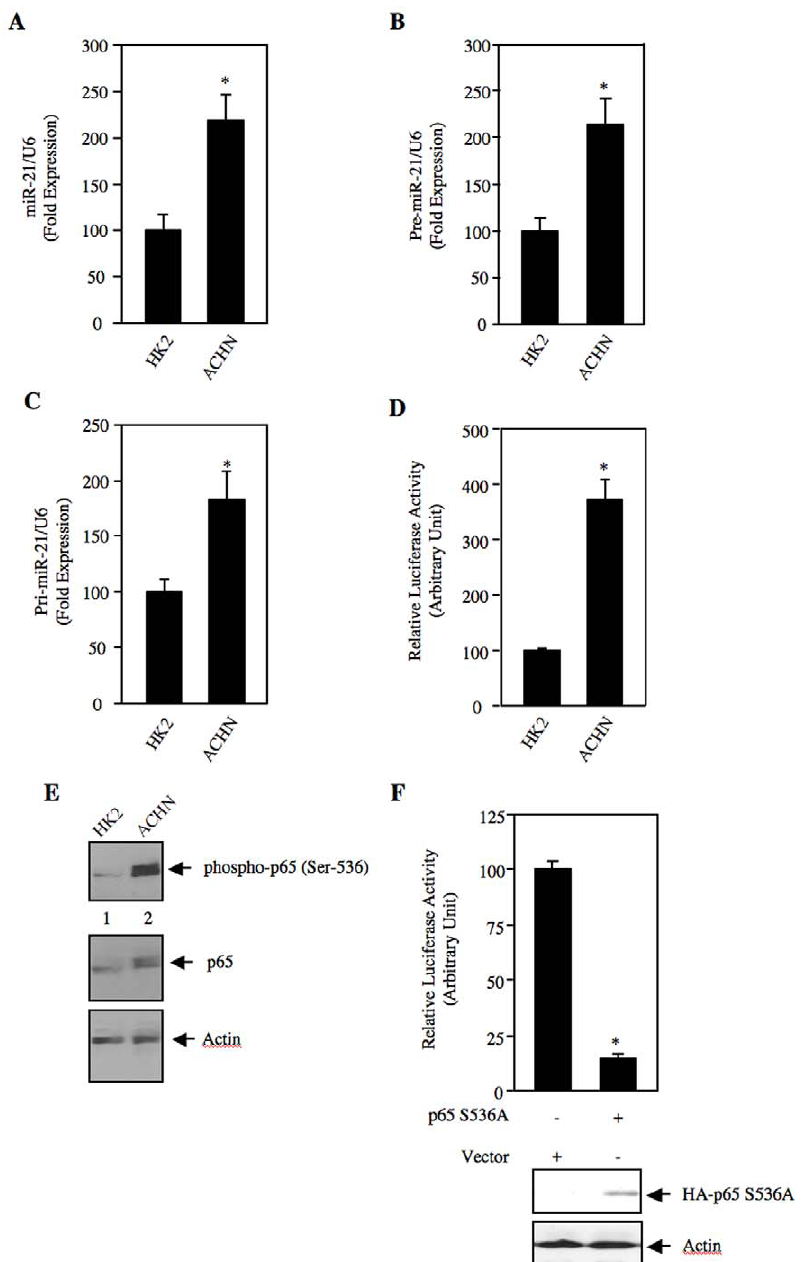
Figure 1. Expression of miR-21 in renal cancer cells. (A – C) Total RNAs from HK2 proximal tubular epithelial cells and ACHN renal cancer cells were used to detect mature miR-21 (panel A), pre-miR-21 (panel B) and pri-miR-21 (panel C) by real time qRT-PCR as described in the Materials and Methods. Mean 6 SE of 4 measurements is shown. In panels A and B, *p =0.004 vs HK2 cells. In panel C, *p =0.02 vs HK2 cells. (D) HK2 and ACHN cells were transfected with miR-21-Luc reporter along with Renilla null plasmid. The cell lysates were used to determine luciferase activity as described in the Materials and Methods. Mean 6 SE of 6 measurements is shown. *p =0.001 vs HK2 cells. (E) Increased phosphorylation of p65 NFkB in renal cancer cells. Lysates of HK2 and ACHN cells were immunoblotted with phospho-p65 (Ser-536), p65 and actin antibodies. (F) Mutant p65 S536A inhibits miR-21 transcription. ACHN renal cancer cells were cotransfected with miR-21-Luc and p65 S536A expression vector. The luciferase activity was determined in the cell lysates. Mean 6 SE of quadruplicate measurements is shown. *p =0.02 vs vector. Bottom panels show expression of the HA-tagged p65 S536A and actin.